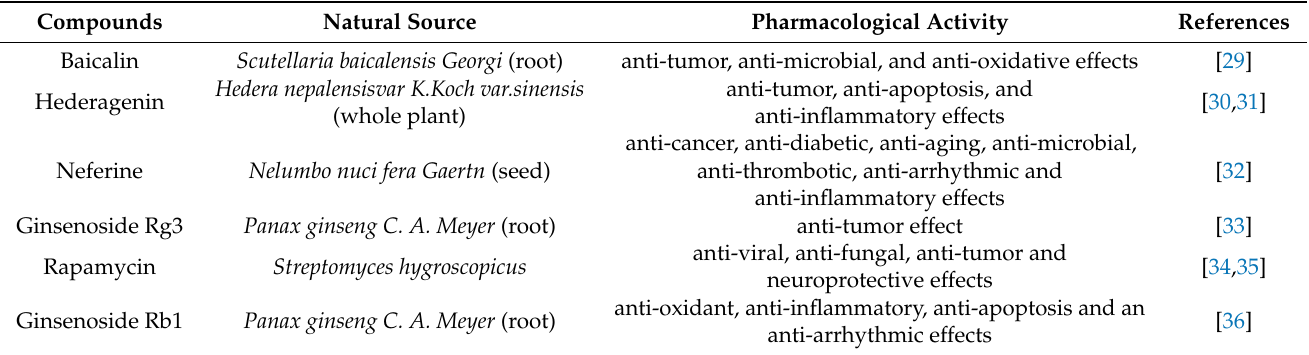
Table 1. The pharmacological activity and the natural source of the six selected